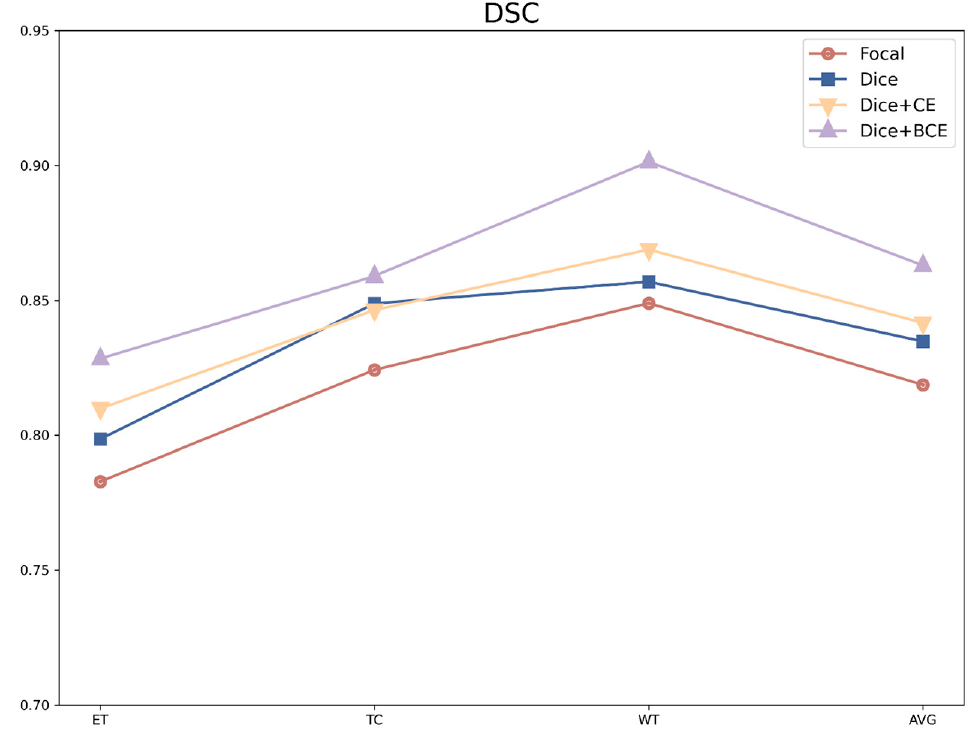
Figure 11. The DSC values for the different losses.